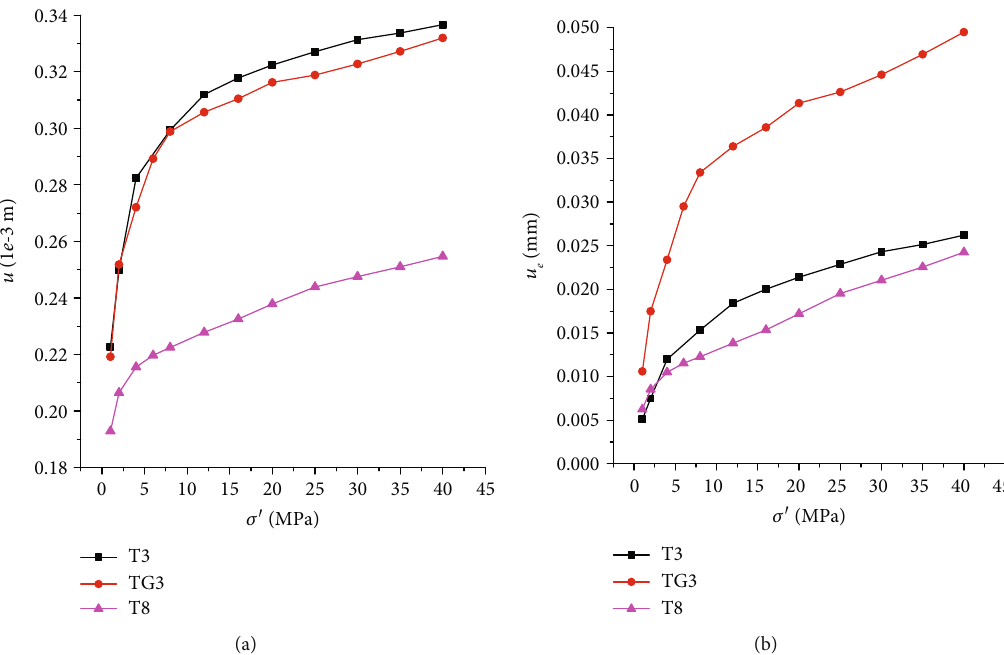
Figure 13: (a) Displacement and (b) average embedded depth versus loading